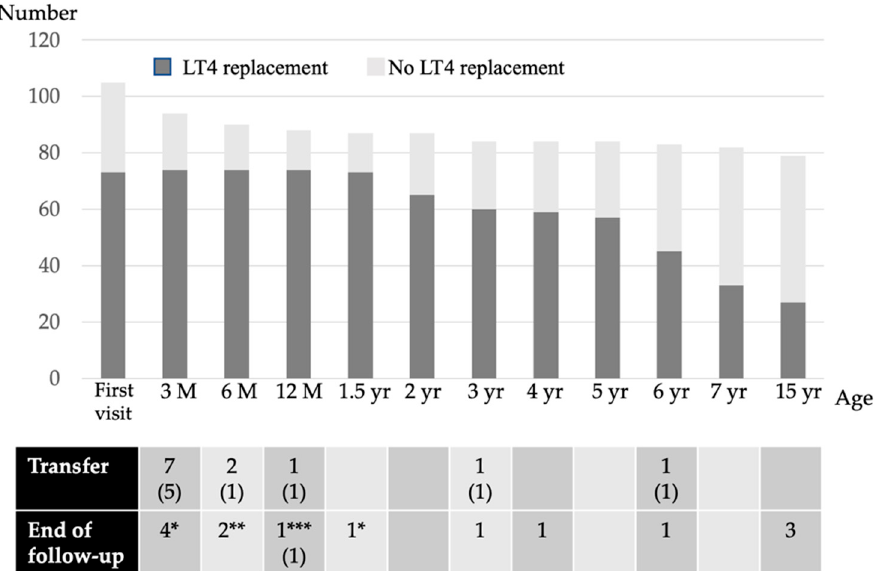
Figure 2. The LT4 replacement status of each age group. M, month; yr, years; ( n ), the number in both parenthesis indicates the number of patients receiving LT4 replacement; * transient hyperthyrotropinemia due to maternal antithyroid drugs or blocking TSH receptor antibody; ** thyroid function was normal from the first visit and the follow-up ended; *** the patient died after cardiac surgery.